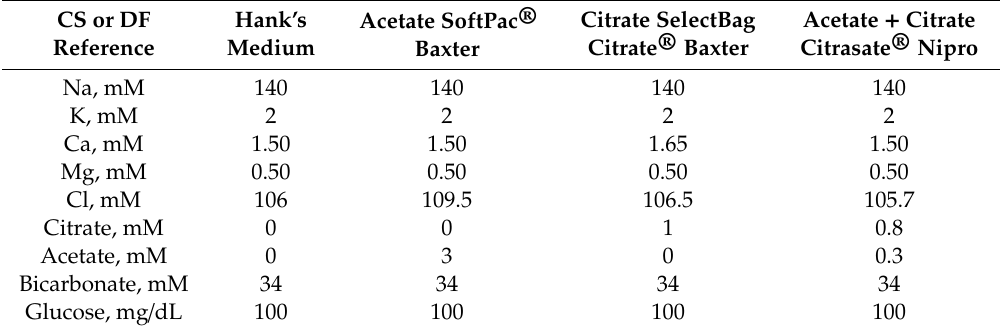
Table 1. Composition of the control solution (CS) and the dialysis fluids (DFs)